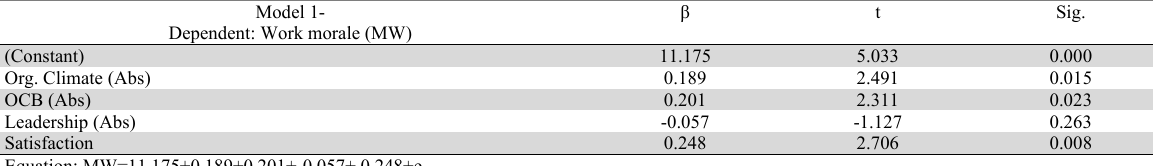
Hypothesis testing with intervening variables